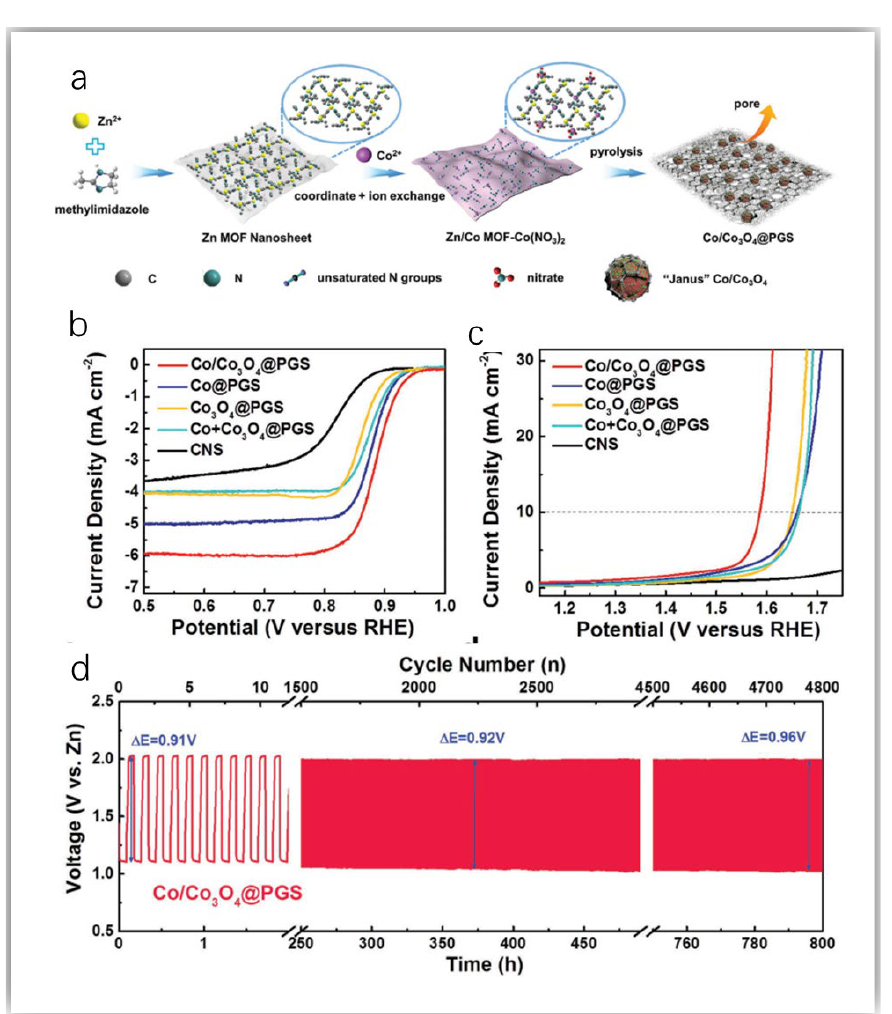
Figure 12. ( a ) Schematic diagram of the preparation of Co/Co 3 O 4 @PGS catalyst, ( b ) ORR polarization curves of Co/Co 3 O 4 @PGS series catalysts, ( c ) OER polarization curves of Co/Co 3 O 4 @PGS series catalysts, ( d ) Galvanostatic cycling stability of Zn–air battery with Co/Co 3 O 4 @PGS catalysts at a current density of 10 mA cm − 2 [106]. Reprinted with permission from Ref. [106]. Copyright © 2018 Wiley-VCH Verlag GmbH & Co. KGaA, Weinheim